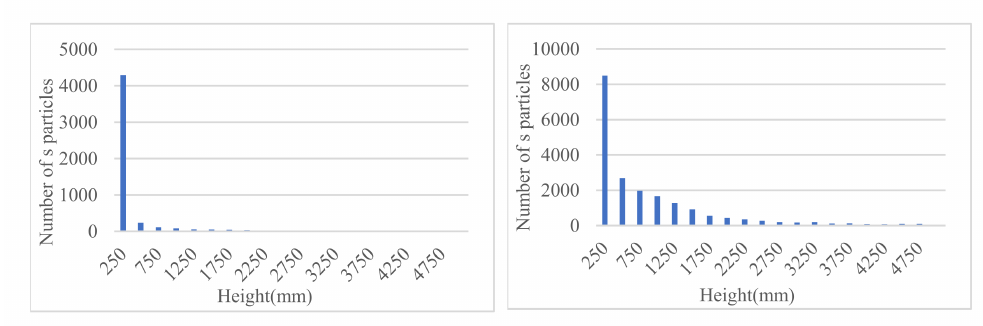
Figure 15. The number of particles by height at 1 s and 4 s.